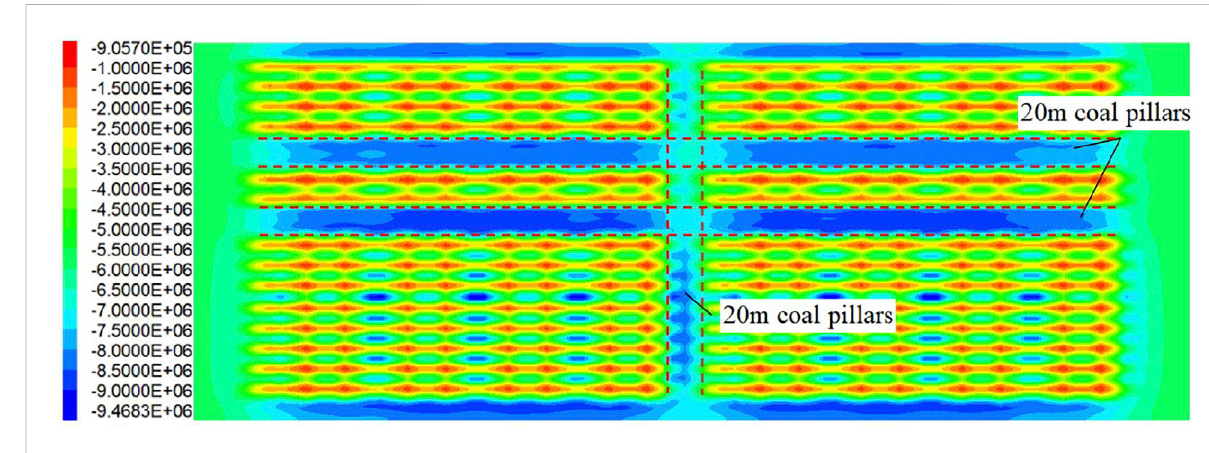
FIGURE 14 Vertical stress distribution of strata at 14m on top of 3# coal seam (Pa).